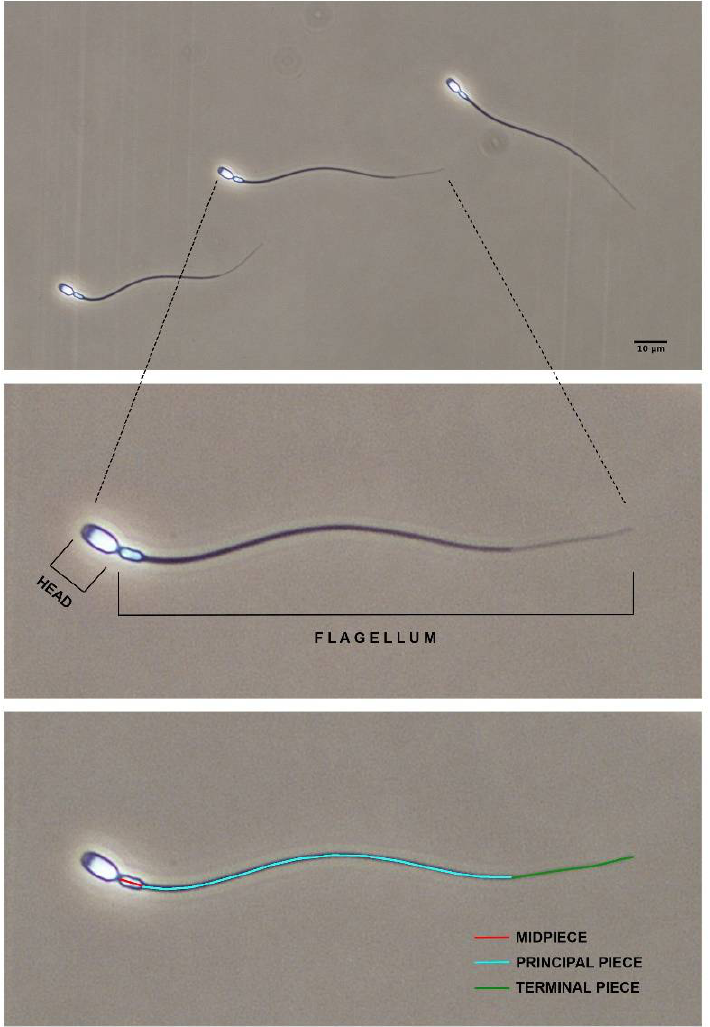
Figure 1. The main structures of bottlenose dolphin spermatozoon ( Tursiops truncatus ): head and flagellum (midpiece, principal piece and terminal piece). The picture was taken under phase-contrast microscopy. Scale bar, 10 µm.